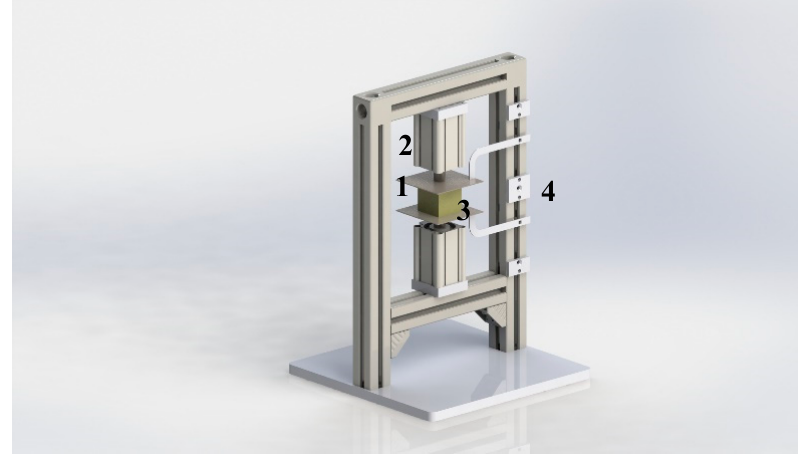
Figure 2. Experimental compression device. 1—Metal plates; 2—Pistons 3—Porous material; 4—Controls varying the pressure to each piston [3].